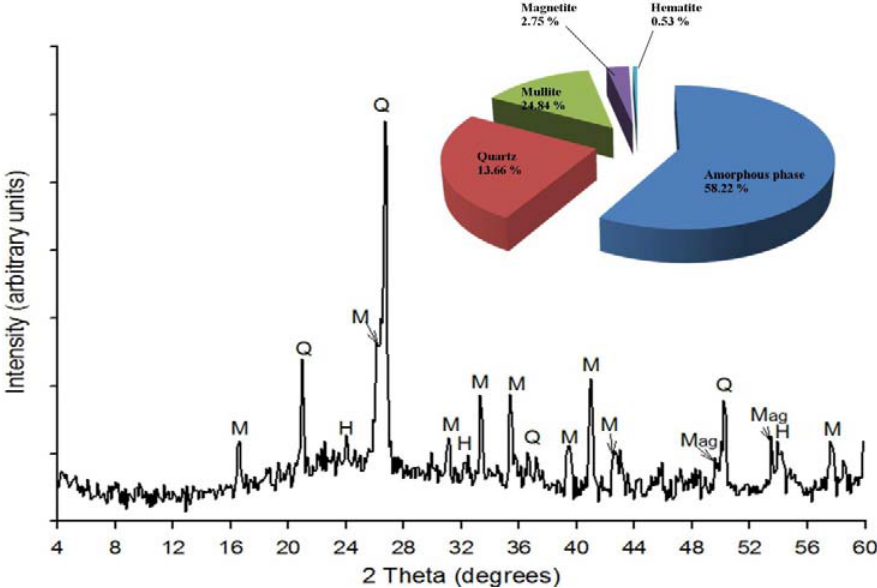
Figure 1. XRD results of the fly ash (Q-Quartz, M-Mullite, Mag-Magnetite and